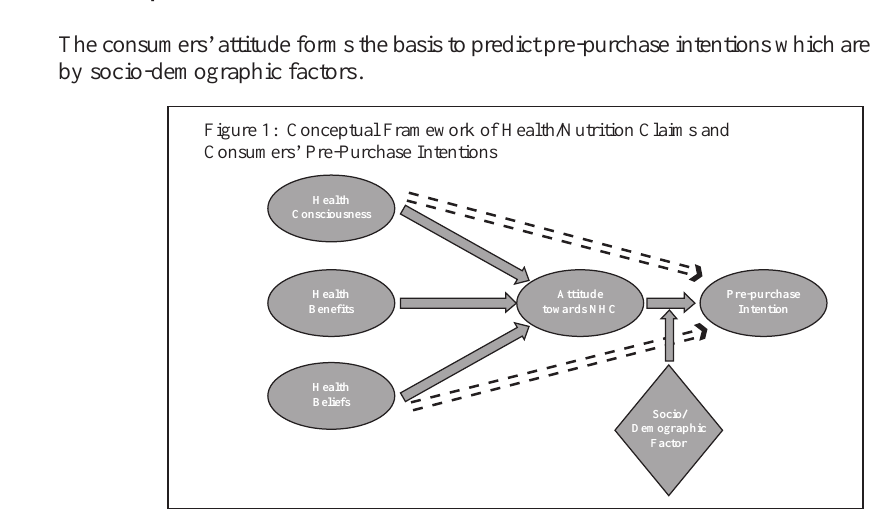
Figure 1: Conceptual Framework of Health/Nutrition Claims and Consumers’ Pre-Purchase